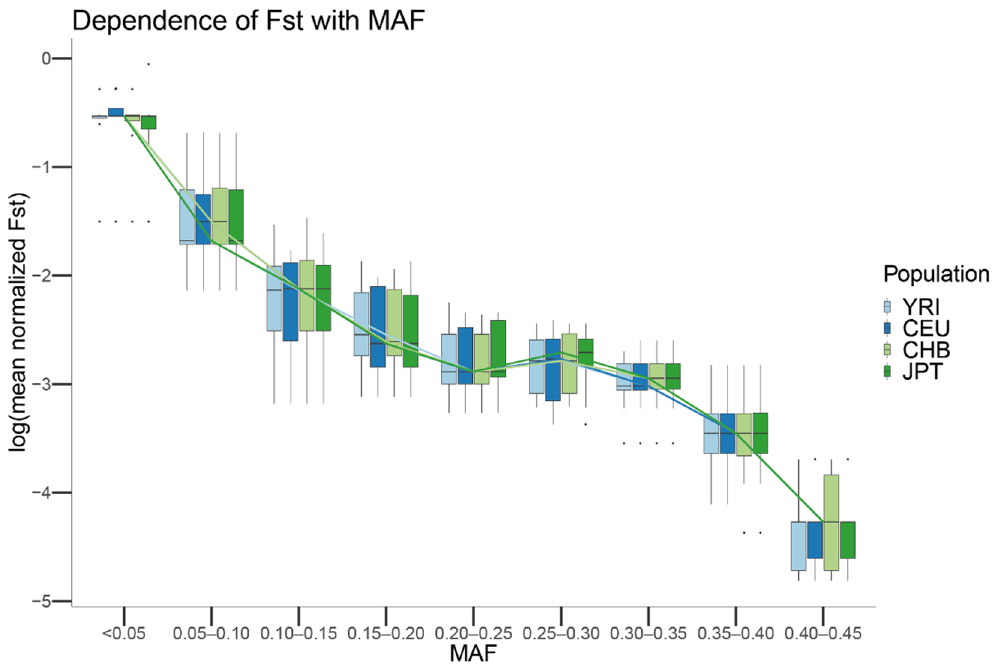
Figure 7. Boxplot of the mean Fst values in log scale by MAF for the CEU, YRI, JPT and CHB populations from 1000G. For each population, the mean Fst of the SNVs with the same MAF was computed. The boxplot was generated by using a MAF binning threshold of 0.05 and plotting the mean Fst in log scale. Lines connect the mean computed for each MAF bin and population.